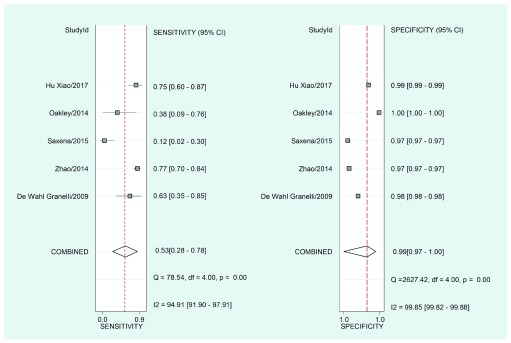
Joint sensitivity and specificity "forest plot" for the physical examination as a screening test to detect critical congenital heart disease in asymptomatic newborns.